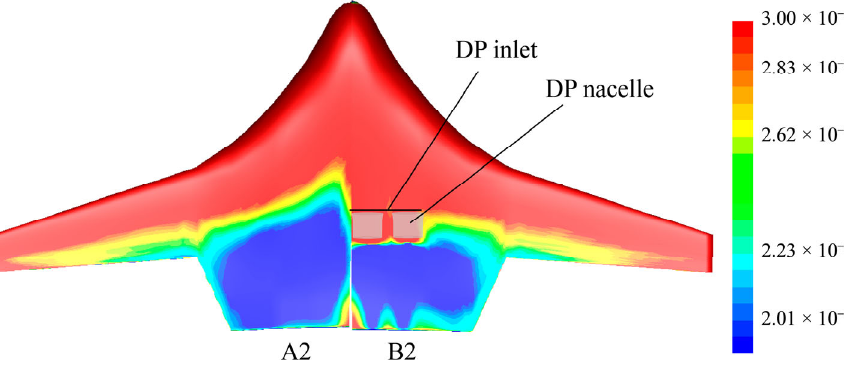
C . C . Figure 11. Comparison of the distribution of surface friction coefficient C f f f .